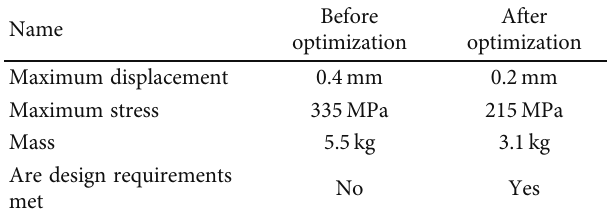
Table 5: Comparison of results before and after optimization. Table 6: Stress